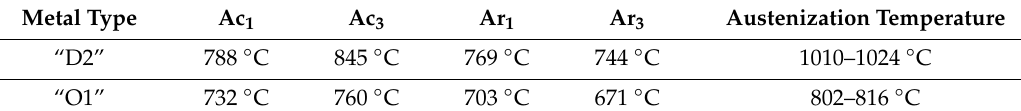
Table 2. Critical and austenization temperatures of “D2” and “O1” tool steels.